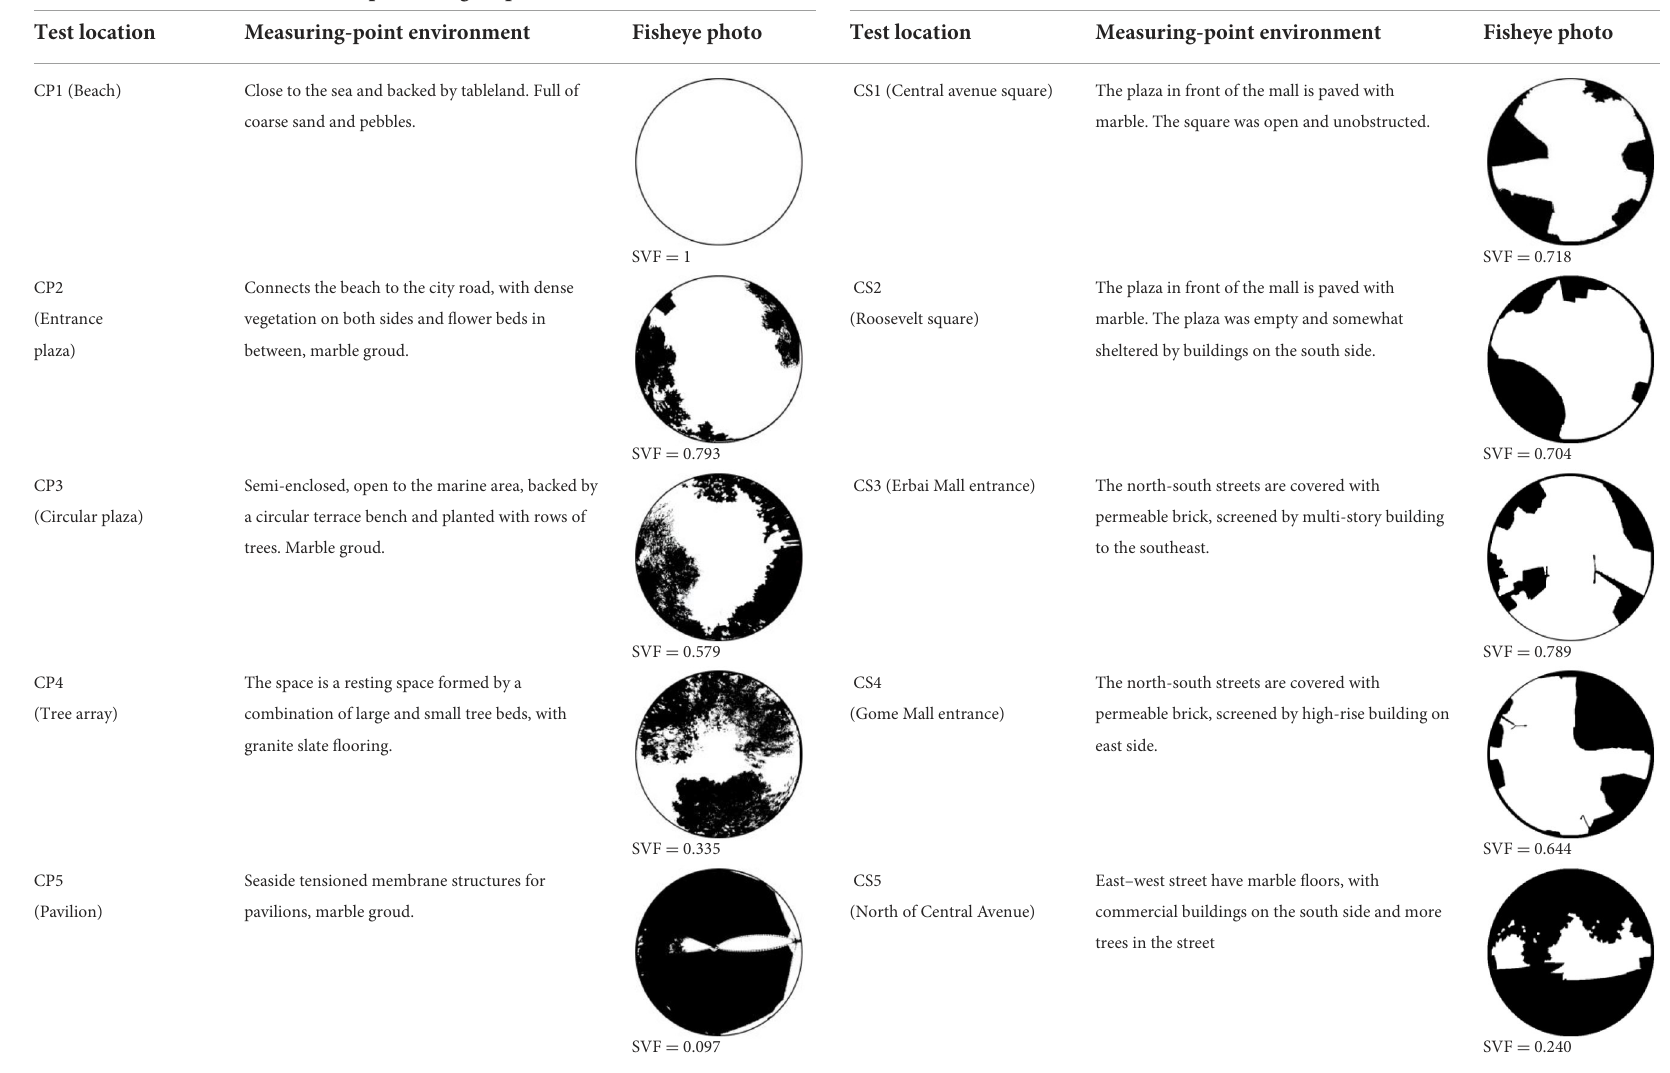
TABLE 1 Characteristics of measuring points of Xinghai park and Xi’an